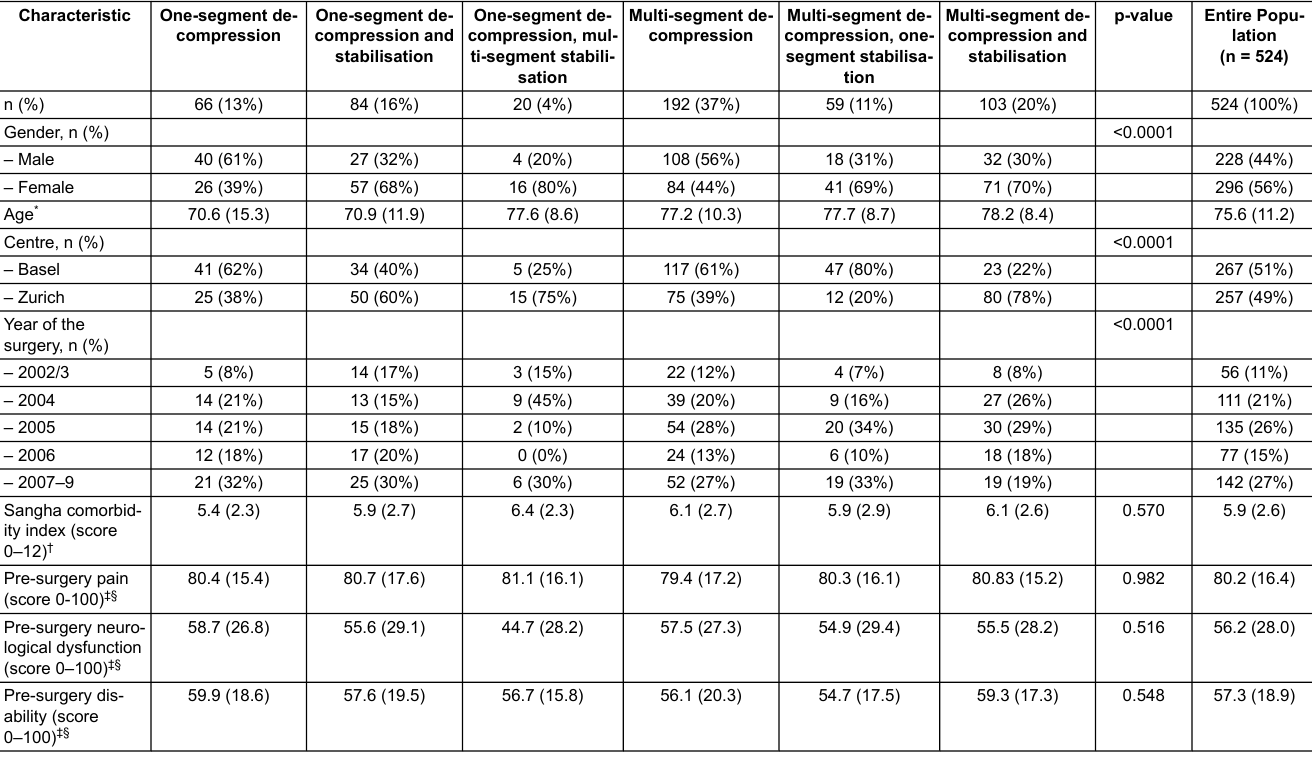
Table 1: Baseline characteristics of the study population.